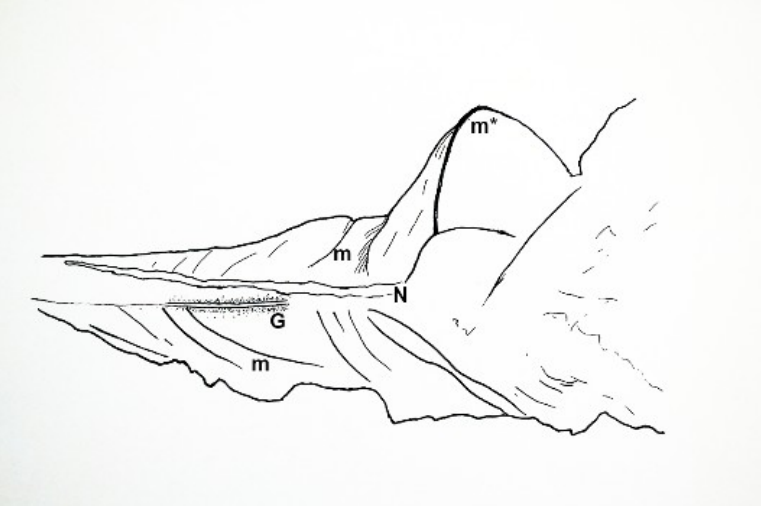
Figure 21. Shenzianyuloma yunnanense nov. gen. nov. sp. IGM 5008. Sketch of tail region from previous image. G , presumed gut trace; m , myomeres; m* , delaminated myomere; N , notochord. Image Credit: Mark McMenamin.